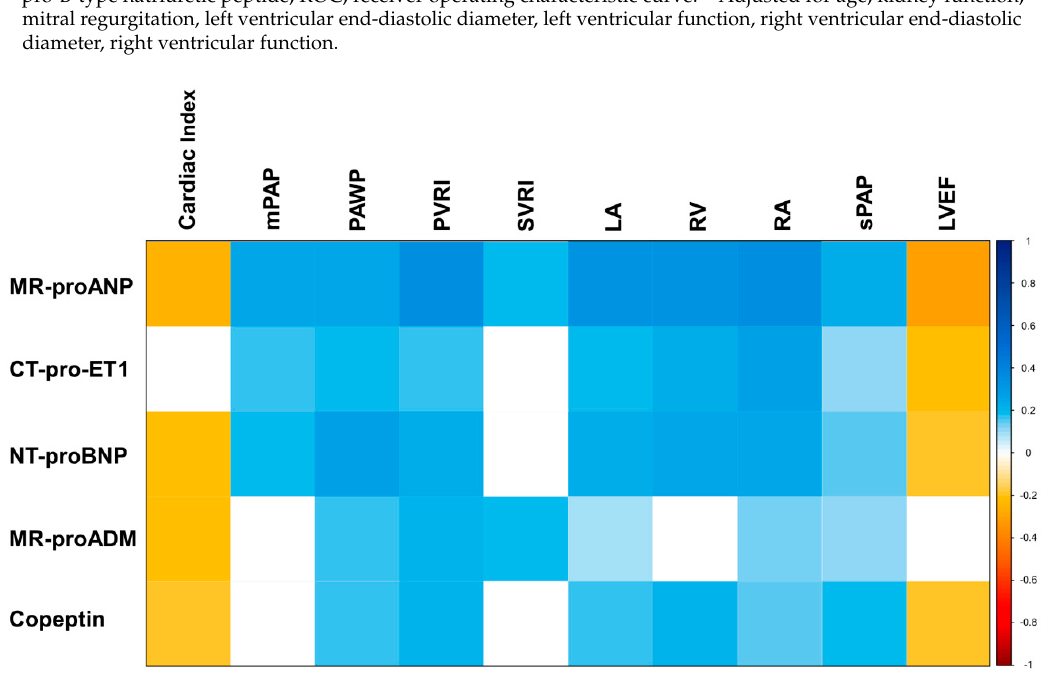
Figure 2. Correlogram investigating the correlation between neurohumoral activation and invasively measured hemodynamic parameters in HFrEF patients with secondary tricuspid regurgitation. Colored fields indicate statistical significance, blue color indicates direct correlation, red color indicates indirect correlation, the shade of the color indicates the correlation coe ffi cient calculated by Pearson-r and referenced in the adjacent scale. CT-pro-ET1, C-terminal pro-endothelin-1; LA, left atrial diameter; LVEF, left ventricular ejection fraction; mPAP, mean pulmonary artery pressure; MR-proADM, mid-regional pro-adrenomedullin; MR-proANP, mid-regional pro-atrial natriuretic peptide; NT-proBNP, N-terminal pro-B-type natriuretic peptide; PAWP, pulmonary artery wedge pressure; PVRI, pulmonary vascular resistance index; RA, right atrial diameter; RV, right ventricular diameter; sPAP, systolic pulmonary artery pressure; SVRI, systemic vascular resistance index.